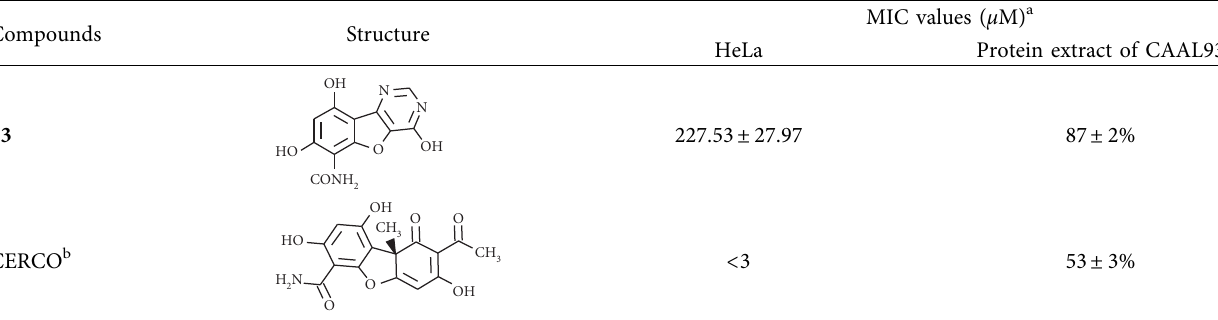
Table 1: Activity of compound 13 on protein extract of CAAL93 and